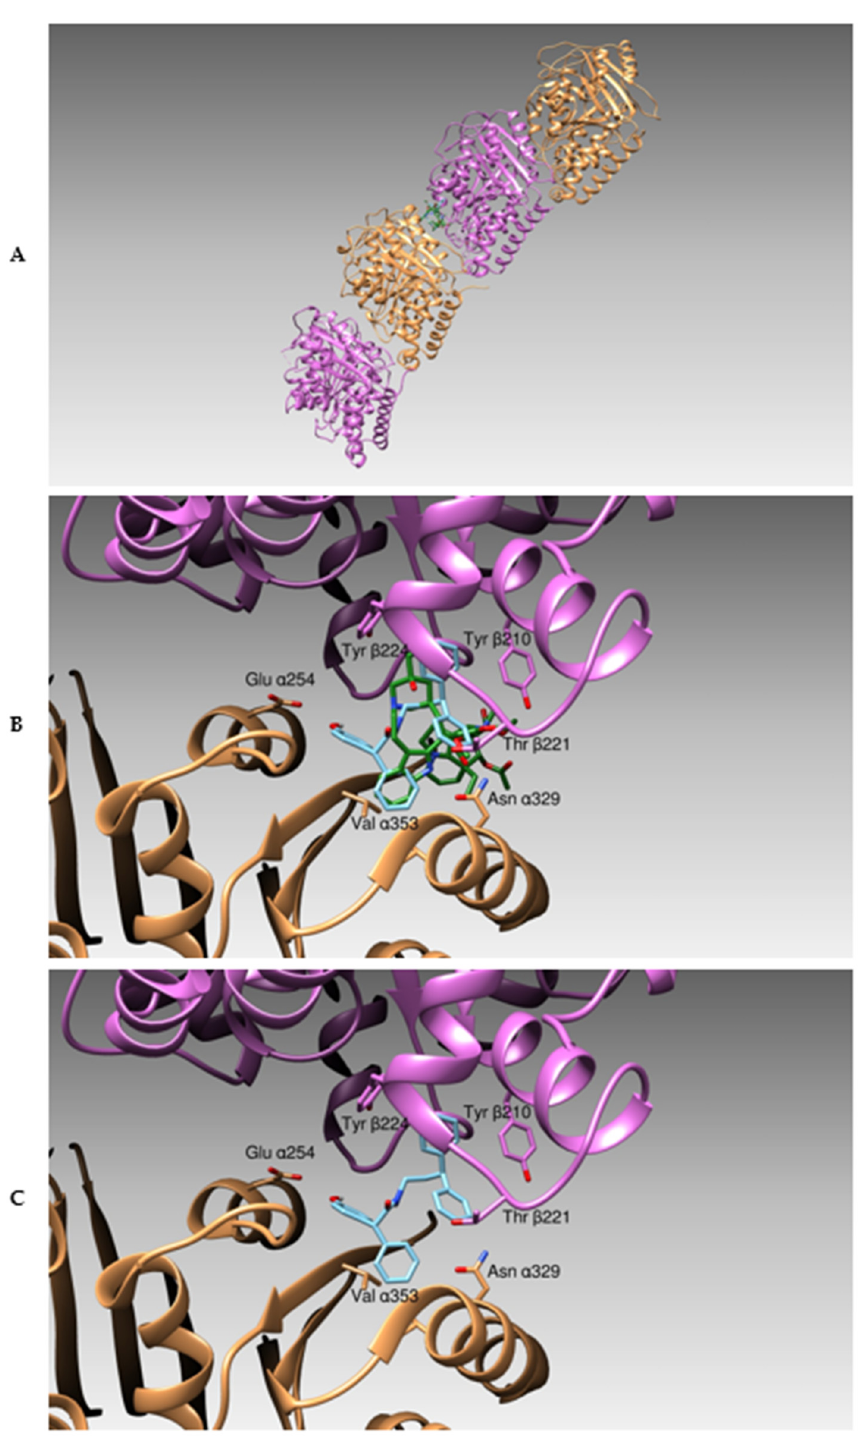
Figure 2. ( A ) Tetrameric alpha-beta-alpha-beta (alpha represented as salmon ribbons, beta as purple ribbons) tubulin assembly. The binding site of derivative 2 (cyan sticks) is located at the interface between beta and alpha subunits, in correspondence to the Vinblastine binding site (highlighted as green sticks). ( B ) Reports the superposition of the Vinblastine (green) binding site (as determined by X-ray Crystallography) to that of the derivative 2 (cyan), as determined by our simulations. ( C ) Reports the interactions between the protein assembly and the derivative 2 .